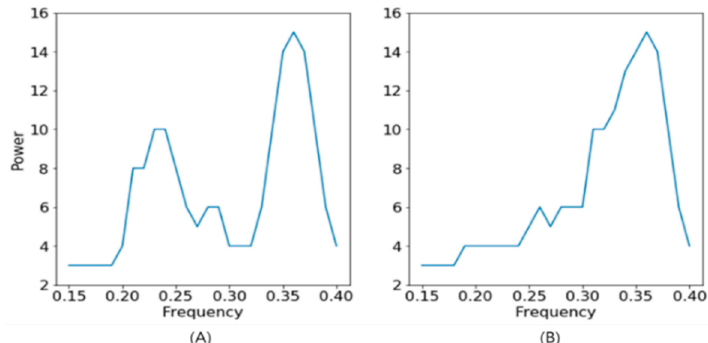
Figure 1. Motivating example 1 in which both cases of (A) and (B) have almost the same values of dominant respiration frequencies (DRFs) ( ≈ 0.36 Hz) and dominant respiration power (DRP) % (when DRP is calculated in the range of 0.02 Hz around DRF), although (B) appears to be in a more regular breathing state than (A). ( A ) HRV-derived respiration with emphasized power at multi frequency. ( B ) HRV-derived respiration with emphasized power at single frequency.